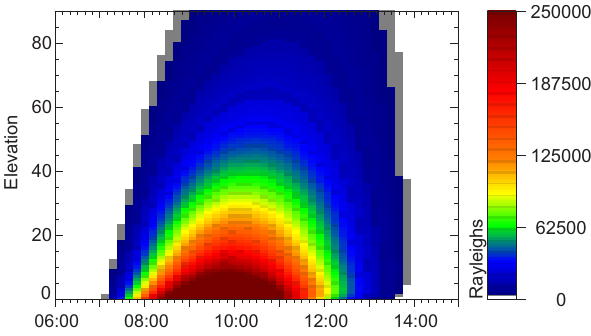
Fig. 11. The modelled UT, time evolution of the MSP 845nm back- ground continuum data on 6 December 2002. This figure models the observations presented in Fig. 2 and is plotted on an identical colour scale.